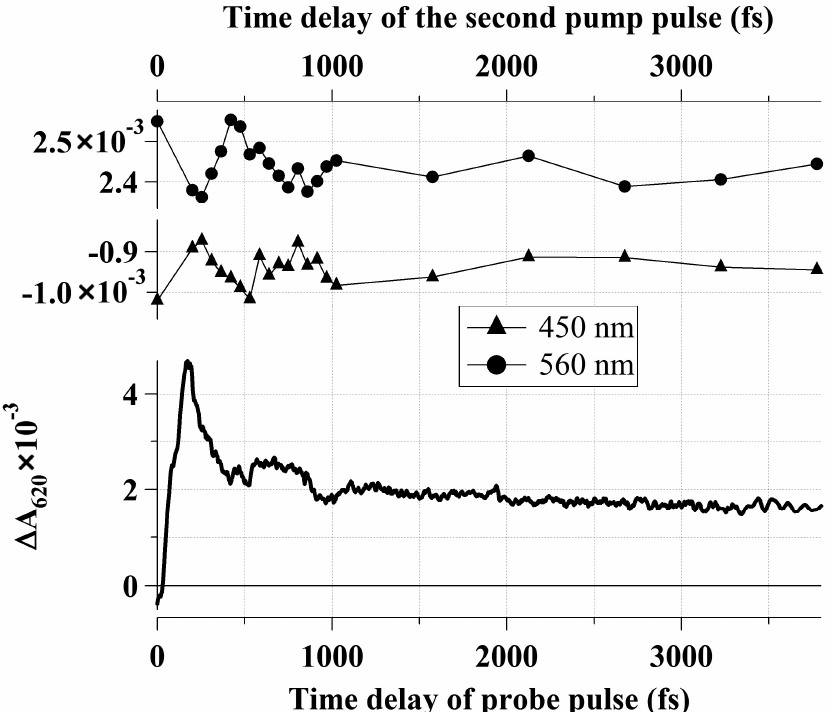
Figure 5. Coherent control of primary ground-state rhodopsin photoproduct phototransition to rhodopsin. ( Bottom ) Kinetic curve of photo-induced rhodopsin absorption under the effect of the 25-fs pump1 at 500 nm and probing at 620 nm. ( Top ) Variation of photo-induced rhodopsin absorption recorded at probe wavelengths of 450 nm (triangles) and 560 nm (circles) 100 ps after pump1 and pump2 excitation at different pump2 time delays (upper abscissa axis). Optical density at a 0-fs time delay was obtained by exclusive rhodopsin excitation by pump1 and is assumed as a